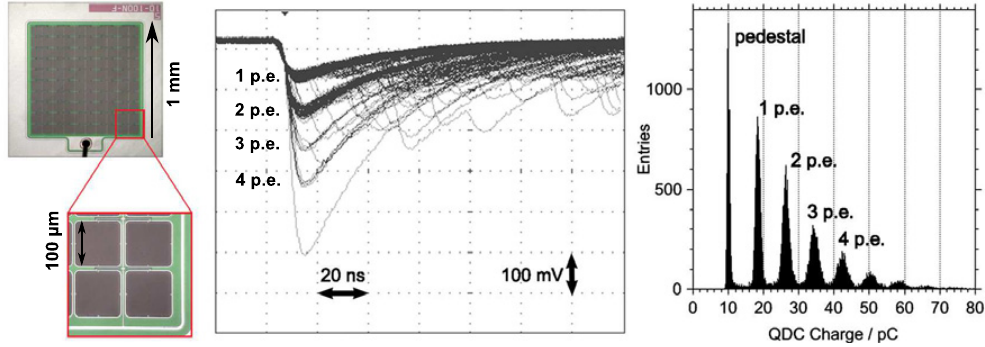
Figure 1. Left : photography of an SiPM (Hamamatsu S10362-11-100C). The sensitive area is 1mm 2 , the cell pitch is 100 (cid:1) m. The green area is dead space leading to a geometric fill factor of 74%. Center : oscilloscope screenshot of amplified SiPM signals. These are noise events since the SiPM is in a light-tight box. Signals from different numbers of cell breakdowns are clearly distinguishable. (p.e. = photon equivalent) Right : measured charge spectrum of signals of an SiPM which detects light from a pulsed LED. Peaks belonging to a certain number of cell breakdowns are clearly distinguishable. (The pedestal is different from zero since the used charge-to-digital-converter (QDC) has an internal pedestal current unequal to zero.) Image collection adapted from